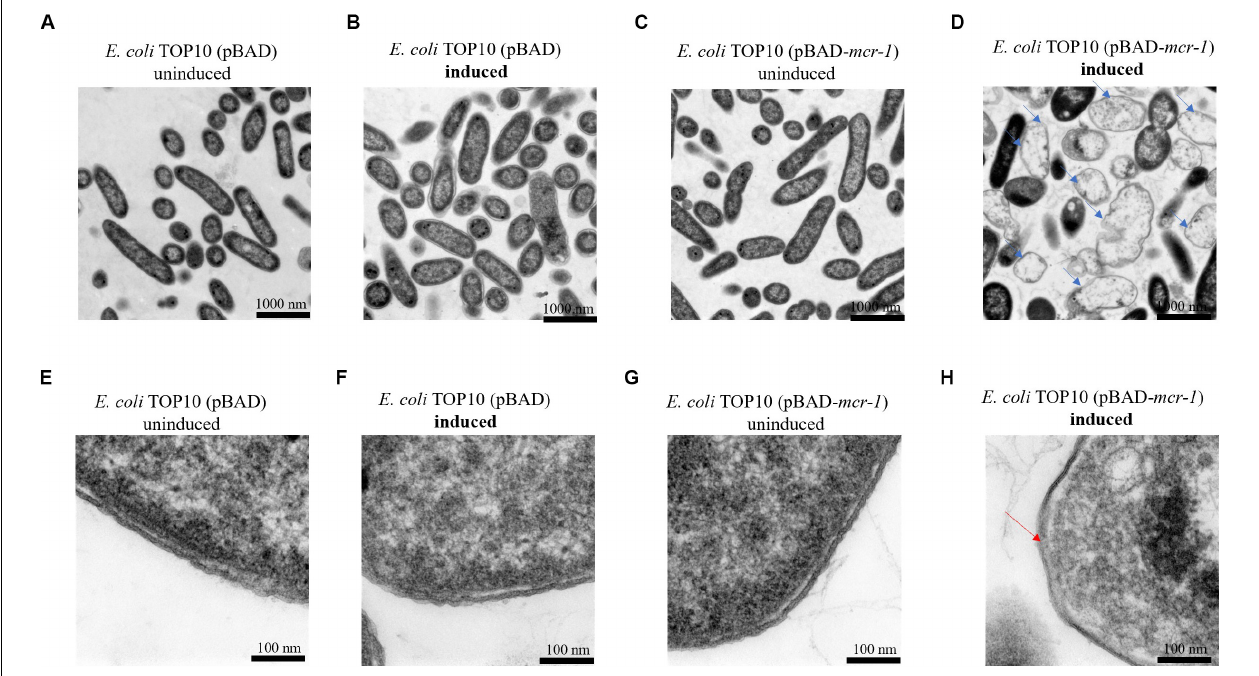
FIGURE 2 | TEM micrographs of E. coli at 8 h with or without induction by 0.2% L-arabinose. (A,B) show E. coli TOP10 + pBAD (the vector control) and (C,D) E. coli TOP10 + pBAD mcr-1 . (E–H) show partially magnified images of figures (A–D) , respectively. All cells in (A–C) have an intact membrane and the electron density of cytoplasmic region is homogeneous. Over-expression of mcr-1 in (D) was associated with membrane damage (red arrow) and cell lysis (blue arrows).